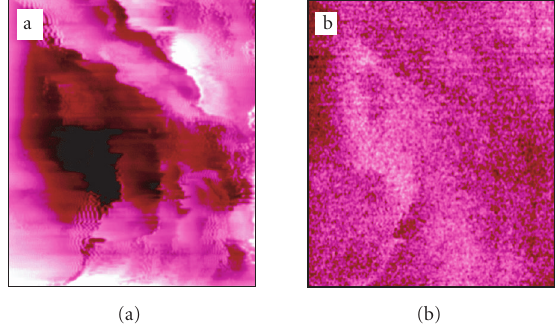
Figure 36: Shear-force AFM (a) (800nm, Z range 200nm) and apertureless SNOM (b) of a shortly charged blood bag surface at a particularly flat site showing widespread optical